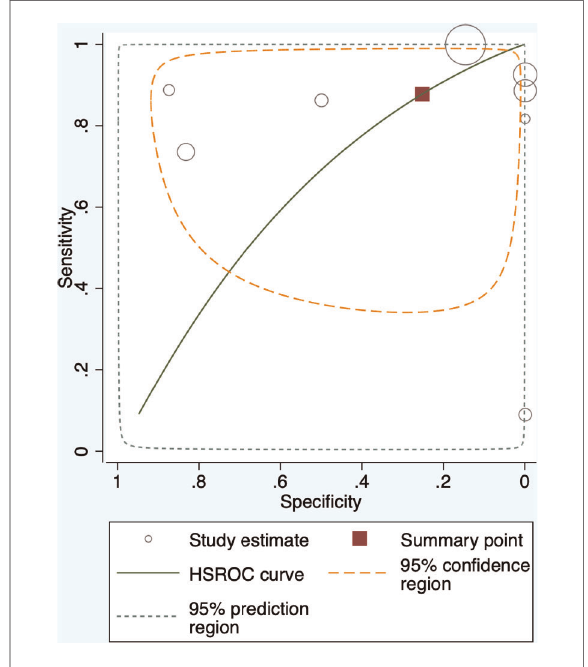
FIGURE 3 Summary Receiver Operating Characteristic (SROC) curve for Intravenous administration of Indocyanine Green for lung cancer localization. HSROC: hierarchical summary receiver operating